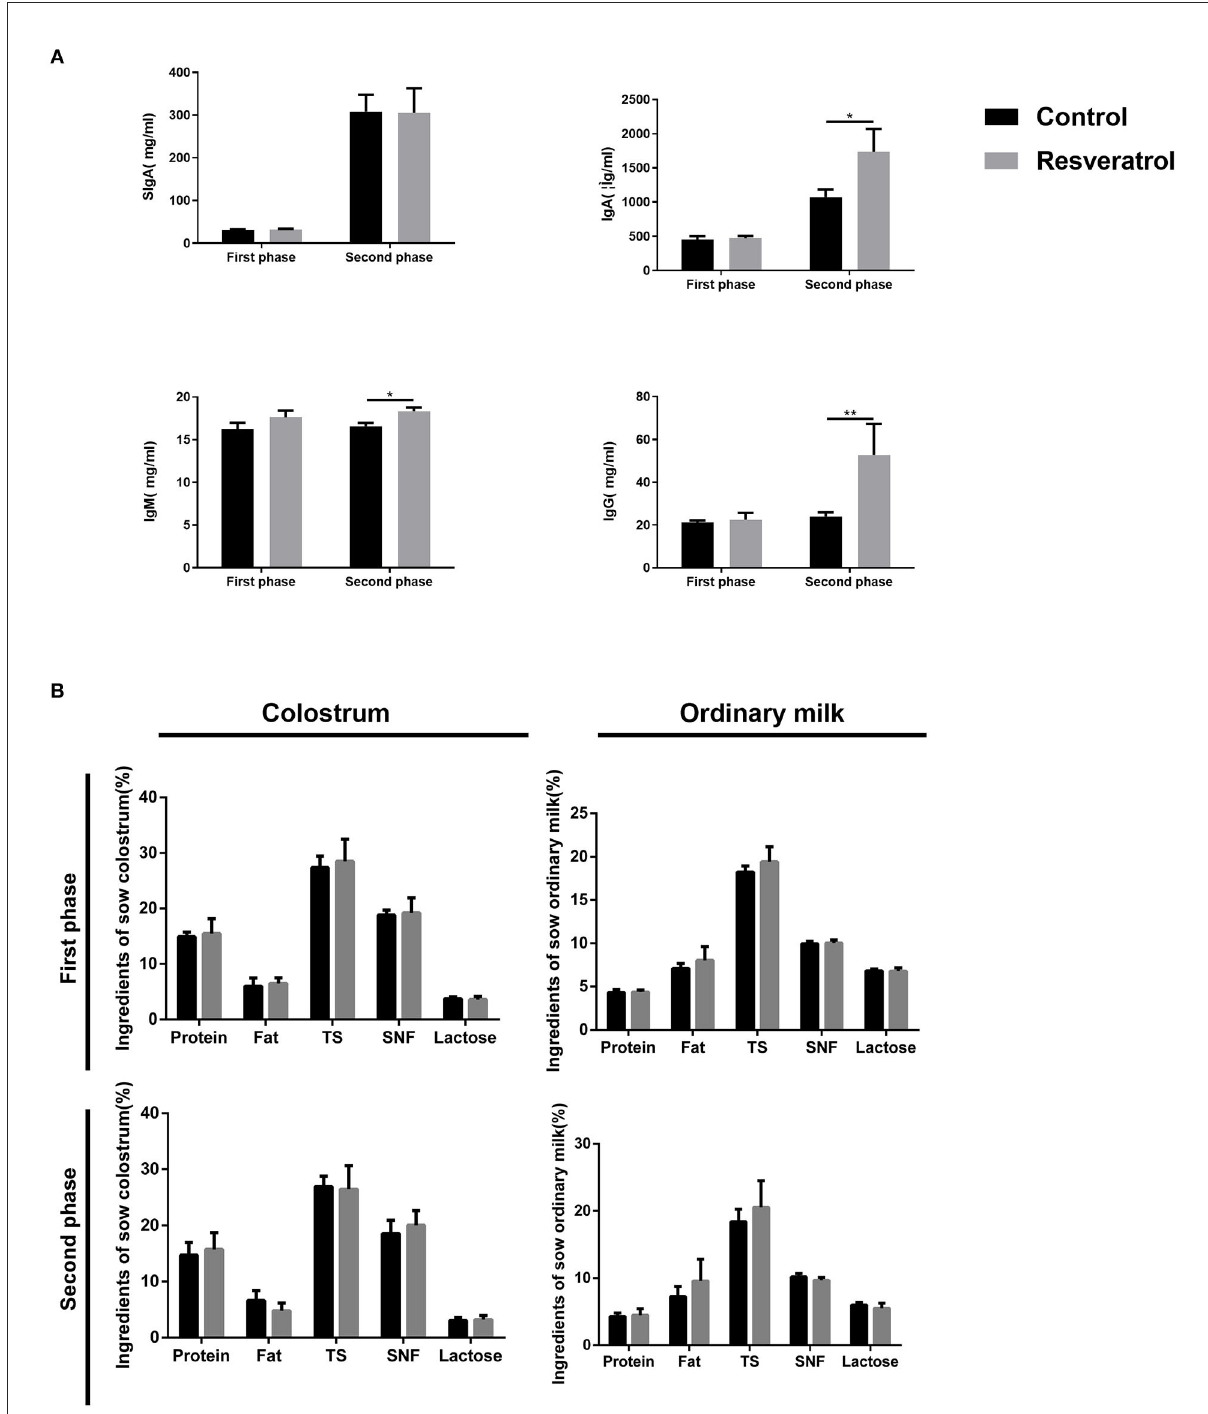
FIGURE4 (A) Effect of dietary resveratrol supplementation during gestation and lactation on the antioxidant status and immunoglobulin of milk. (B) Effect of dietary resveratrol supplementation during gestation and lactation on the composition of colostrum and ordinary milk. Data were expressed as means ± SEM of at least three independent experiments. TS, total solid; SNF, solid non-fat. * p < 0.05, ** p <